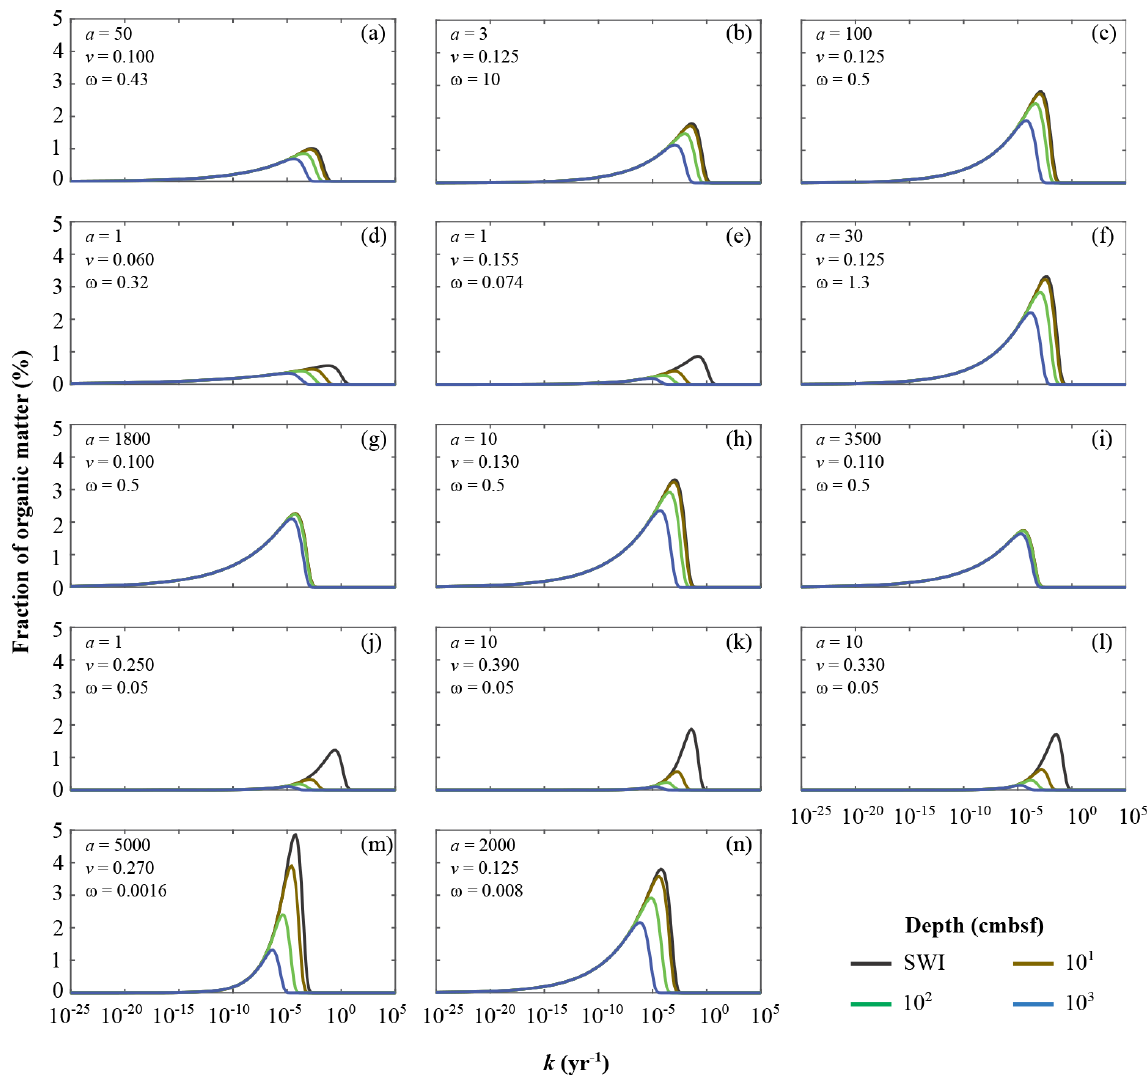
Figure 5. Apparent organic matter reactivity k initial probability distributions and downcore evolution as a function of burial depths: (a) Sev- ern estuary; (b) Rhone pro-delta; (c) Rhone shelf; (d) Aarhus Bay; (e) Arkona Basin; (f) Helgoland mud area, North Sea; (g) Skagerrak – S10; (h) Skagerrak – S11; (i) Skagerrak – S13; (j) Arabian Sea – OMZ core; (k) Arabian Sea – OMZ transition; (l) Arabian Sea – below OMZ; (m) Bering Sea; (n) Argentine